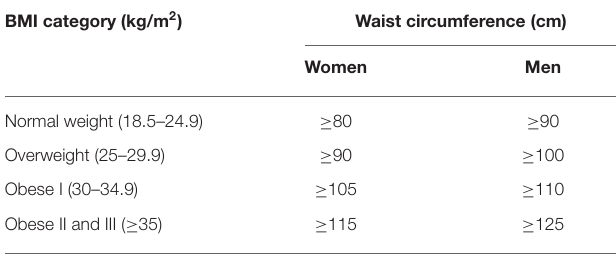
TABLE 1 | Waist circumference thresholds stratified by